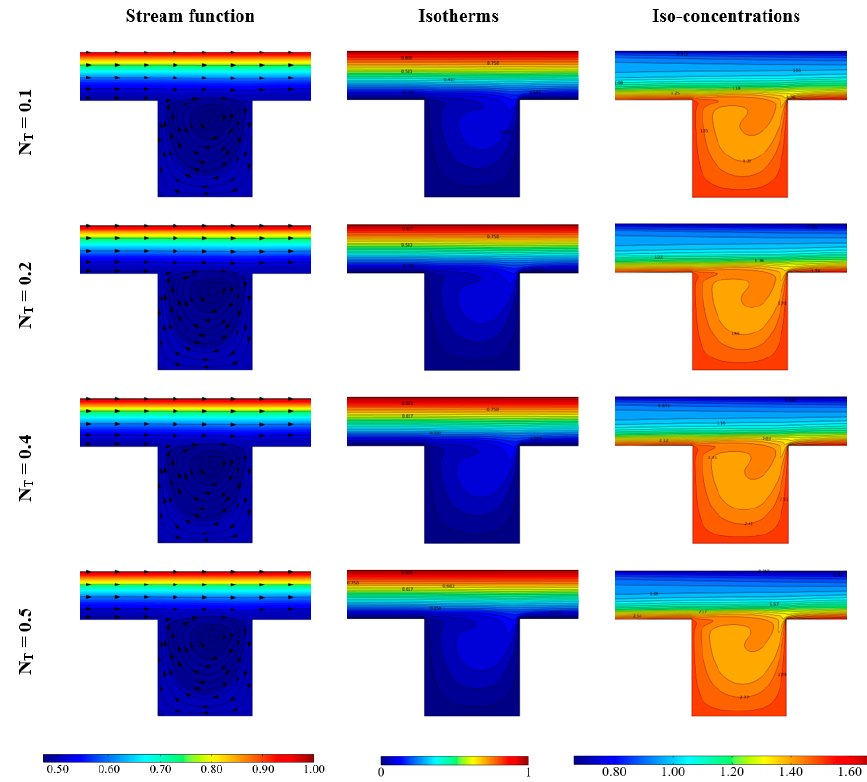
Figure 6. Stream function, Isotherms and Iso-concentration for various N T number and Pr = 6.2, Re = 100, Le = 1, N B = 0.1.